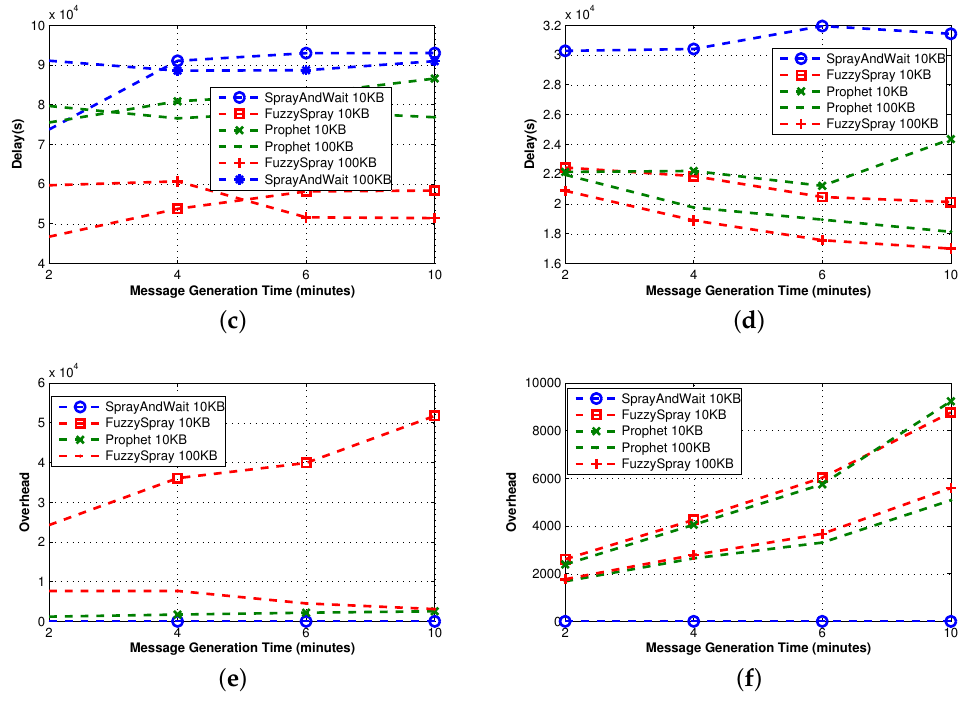
Figure 6. Single technique protocols: LW ( a , c , e ) vs. Infocom ( b , d , f ). For the sake of readability: if the difference between the 100-KB and 10-KB cases for a protocol is within 5%, we do not show the 100-KB case.